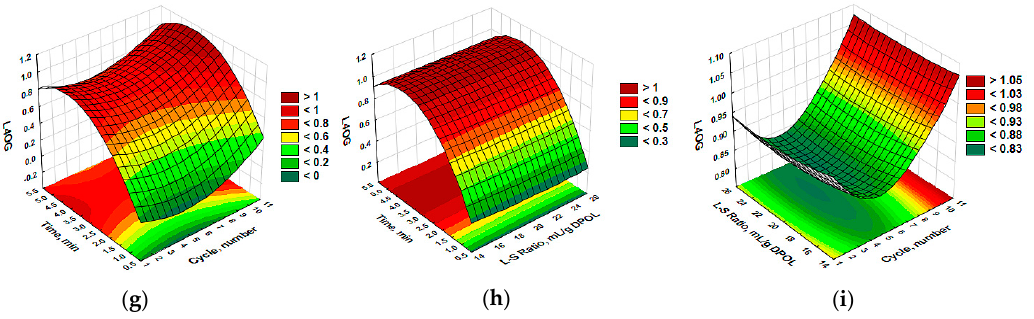
Figure 4. Response surface plots showing the effect of sonication time ( X 3 ) and number of cycles ( X 1 ) on the concentrations of ( a ) oleuropein (OLE), ( d ) verbascoside (VER), and ( g ) luteolin-4 ′ - O -glucoside (L4OG); the effect of sonication time ( X 3 ) and liquid–solid (L–S) ratio ( X 2 ) on the concentrations of ( b ) OLE, ( e ) VER, and ( h ) L4OG; the effect of L–S ratio ( X 2 ) and number of cycles ( X 3 ) on the concentrations of ( c ) OLE, ( f ) VER, and ( i ) L4OG in olive leaves as a function of desirable values at optimal conditions and examined parameters of UAE (number of cycles = 10; L–S ratio = 15; extraction time = 4 min) for all dependent variables. All data presented are mean values of two independent experiments ( n = 2).